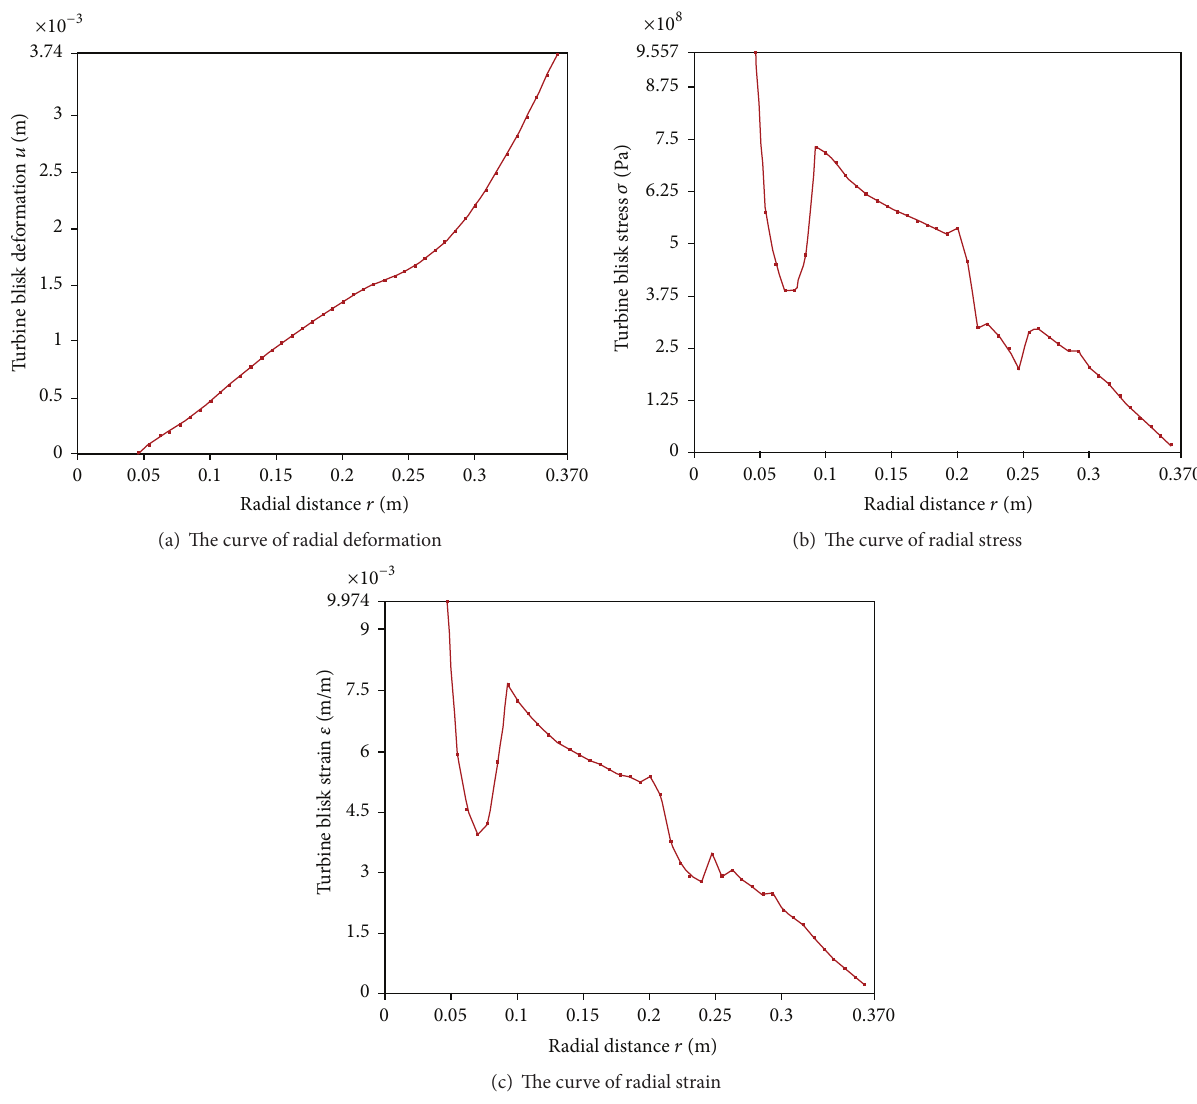
Figure 8: The curves of turbine blisk deformation, stress, and strain along radial direction.